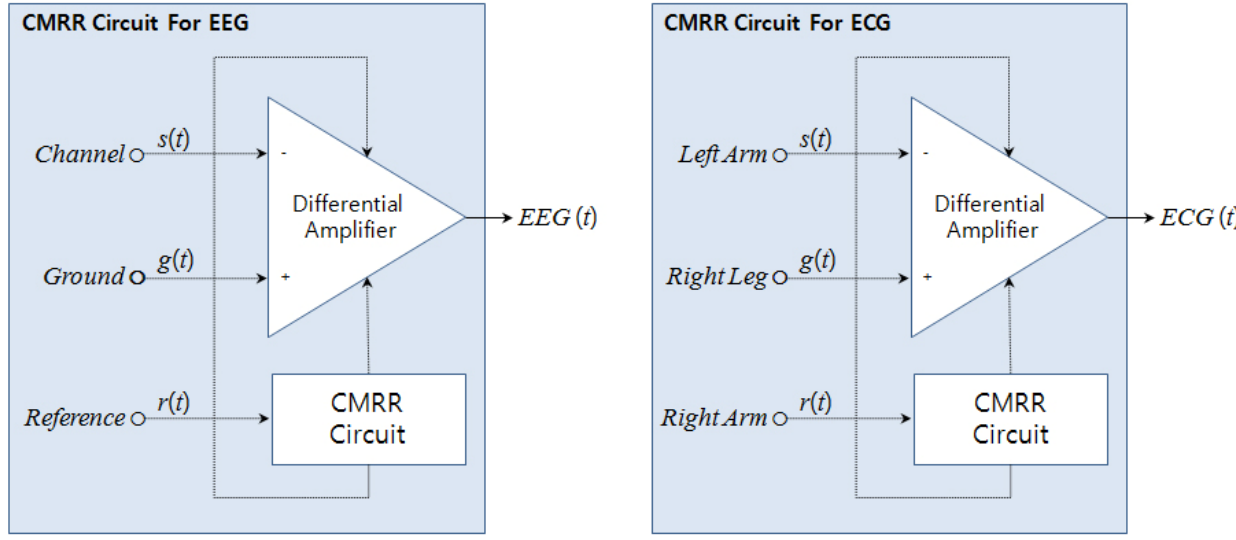
Figure 2. Structure of Common-mode rejection ratio for EEG and